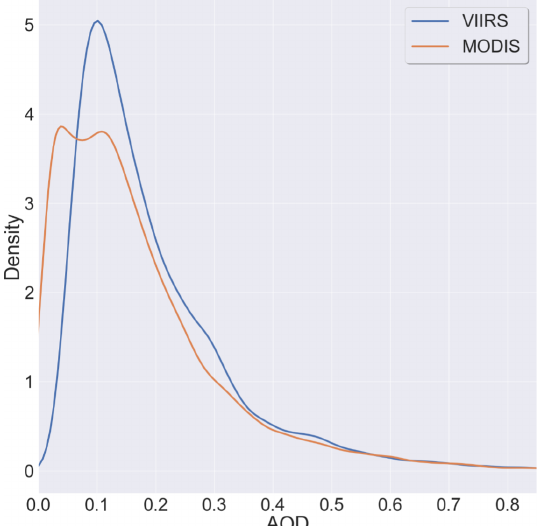
Figure 11. Global satellite AOD distribution over land (DJF pe- riod).